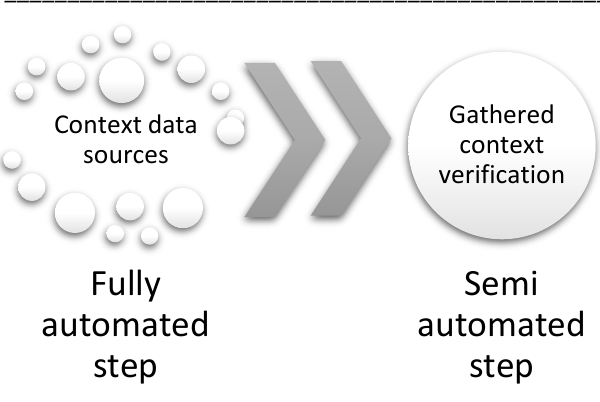
Fig. 4. Contextual information verification approach steps.